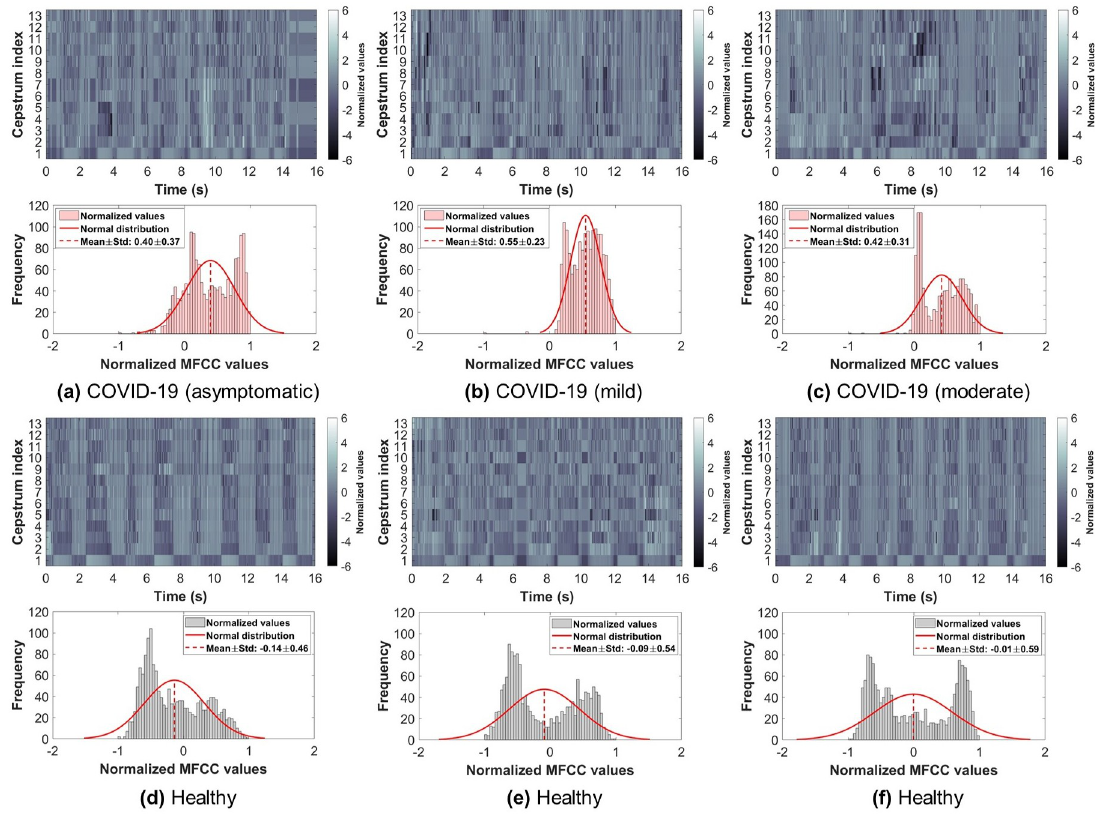
Fig 6. Examples of the mel-frequency cepstral coefficients (MFCC) extracted from the deep breathing dataset and illustrated as a normal distribution of summed coefficients. Showing: (a-c) COVID-19 subjects (asymptomatic, mild, moderate), (d-f) healthy subjects. https://doi.org/10.1371/journal.pone.0262448.g006 classified as carrying COVID-19. The correct predictions number was slightly lower using the deep breathing dataset with a 109 and 112 for COVID-19 and healthy subjects, respectively. In addition, wrong predictions were also slightly higher with 11 COVID-19 and 8 healthy sub- jects. Therefore, the confusion matrices show percentages of proportion of 94.20% and 90.80% for COVID-19 subjects using the shallow and deep datasets, respectively. On the other hand, healthy subjects had percentages of 95.00% and 93.30% for both datasets, respectively. The evaluation metrics (Fig 7(b)) calculated from these confusion matrices returned an accuracy measure of 94.58% and 92.08% for the shallow and deep datasets, respectively. Table 2. Normal distribution analysis (mean ± std) of the combined mel-frequency cepstral coefficients (MFCCs) using the shallow breathing dataset.